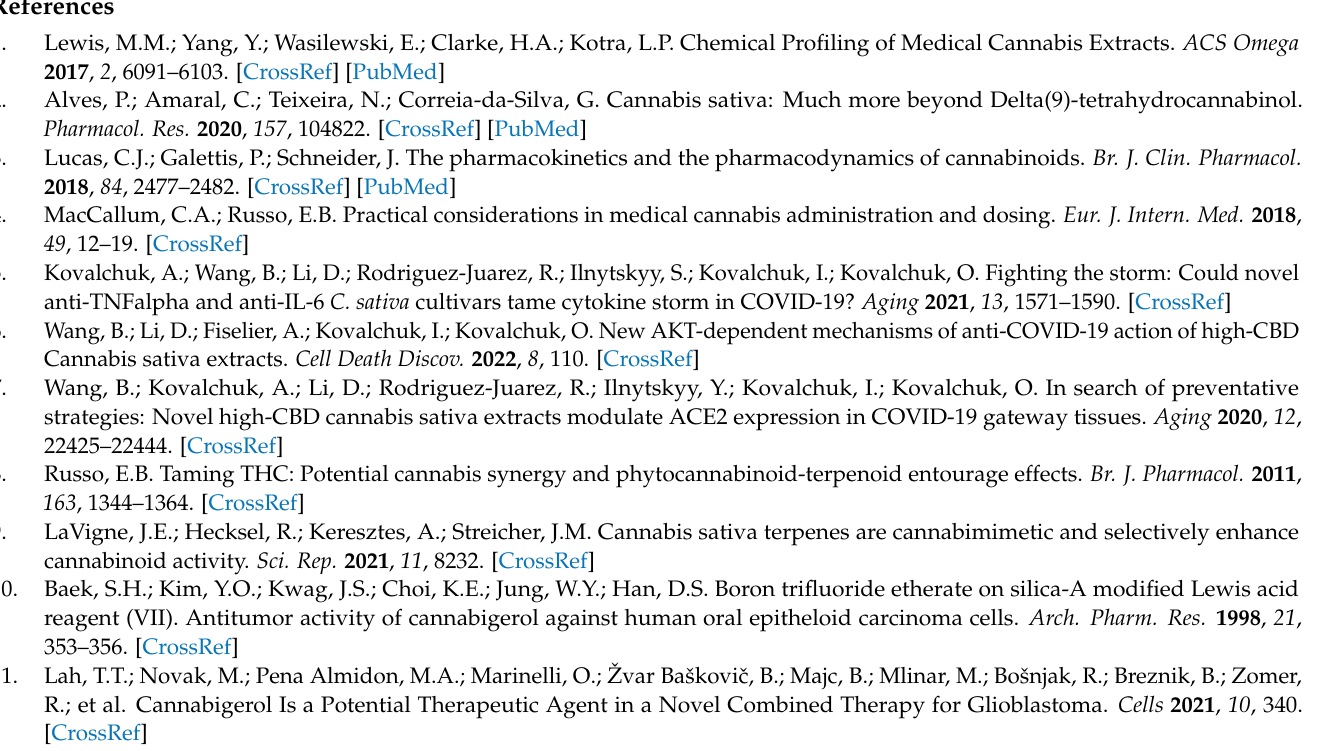
cultivars. Table S1: Enrichment of cannabinoids upon extraction; Table S2: Concentration of terpenes in the flower extracts, ug/ul; Table S3: CCE for various clustering methods; Table S4: Dunn index for various clustering methods; Table S5: Association between terpene content and anti-cancer activity; Table S6: Association between terpene or cannabinoid content and IL-6 expression; Table S7: Association between cannabinoid content and COX2 expression; Table S8: Association between terpene and cannabinoid content. Table S9. List of cultivars used in the